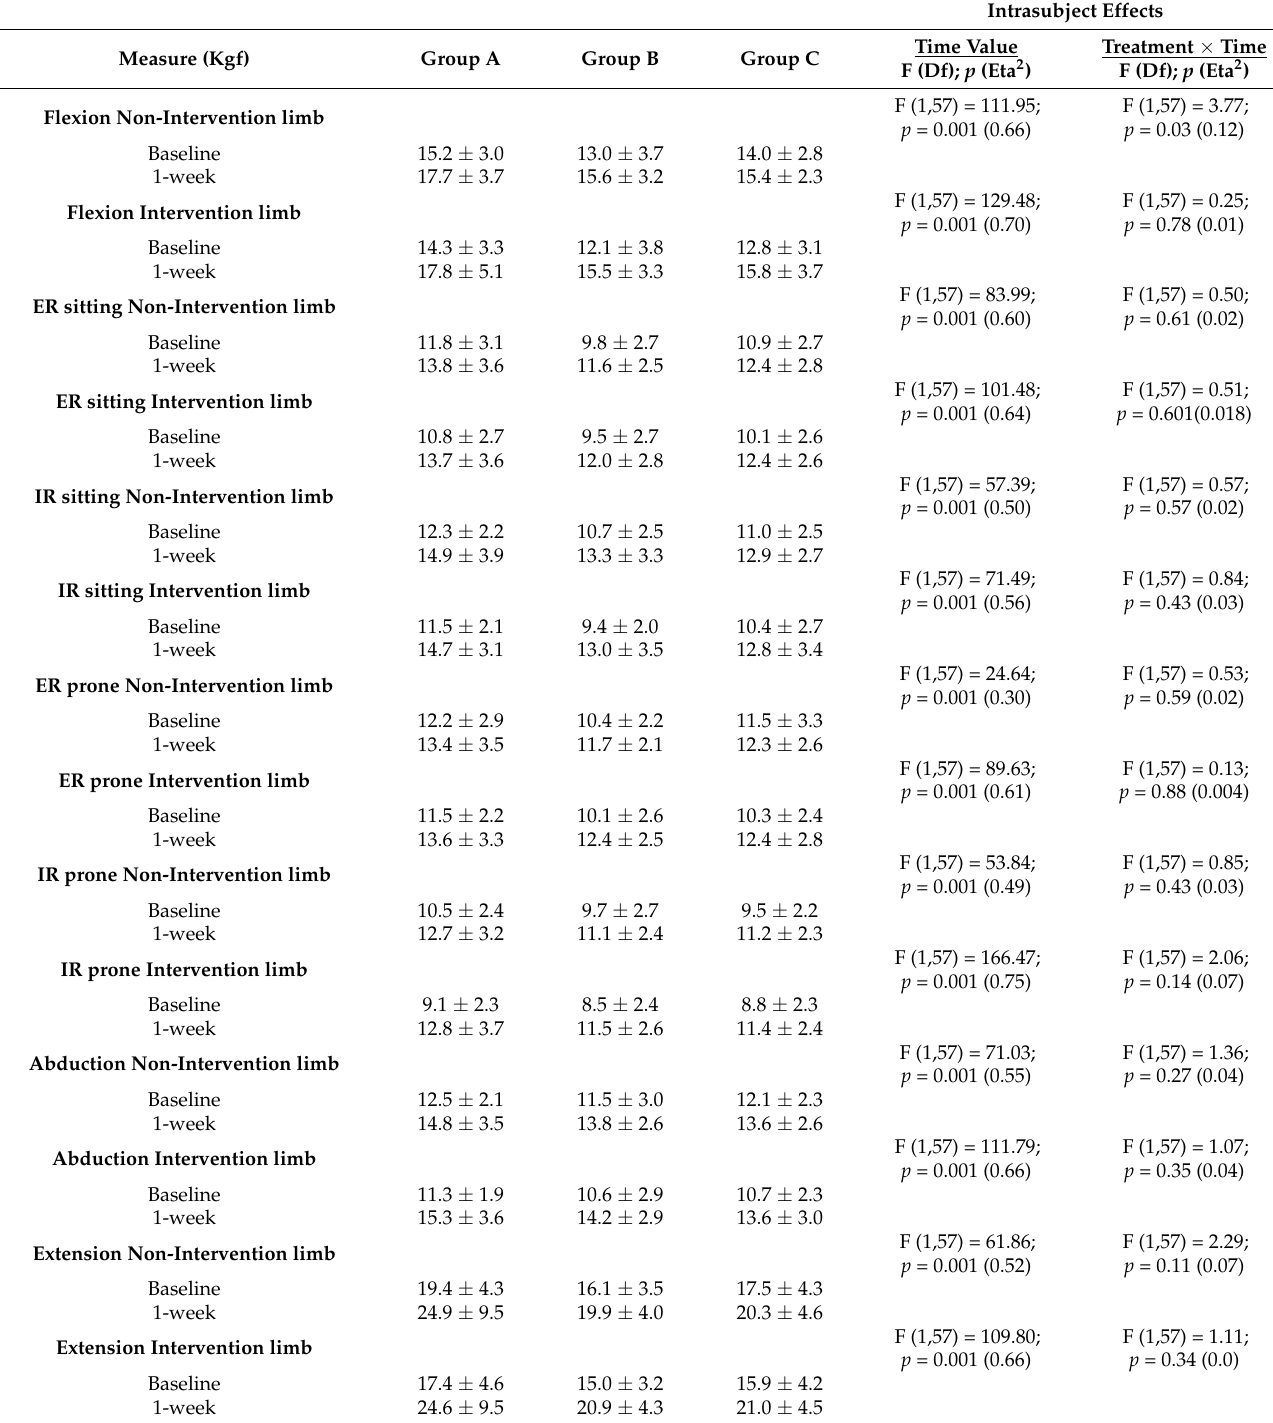
Table 3. Flexion, extension, external and internal rotation, abduction strength for both limbs intrasub- ject